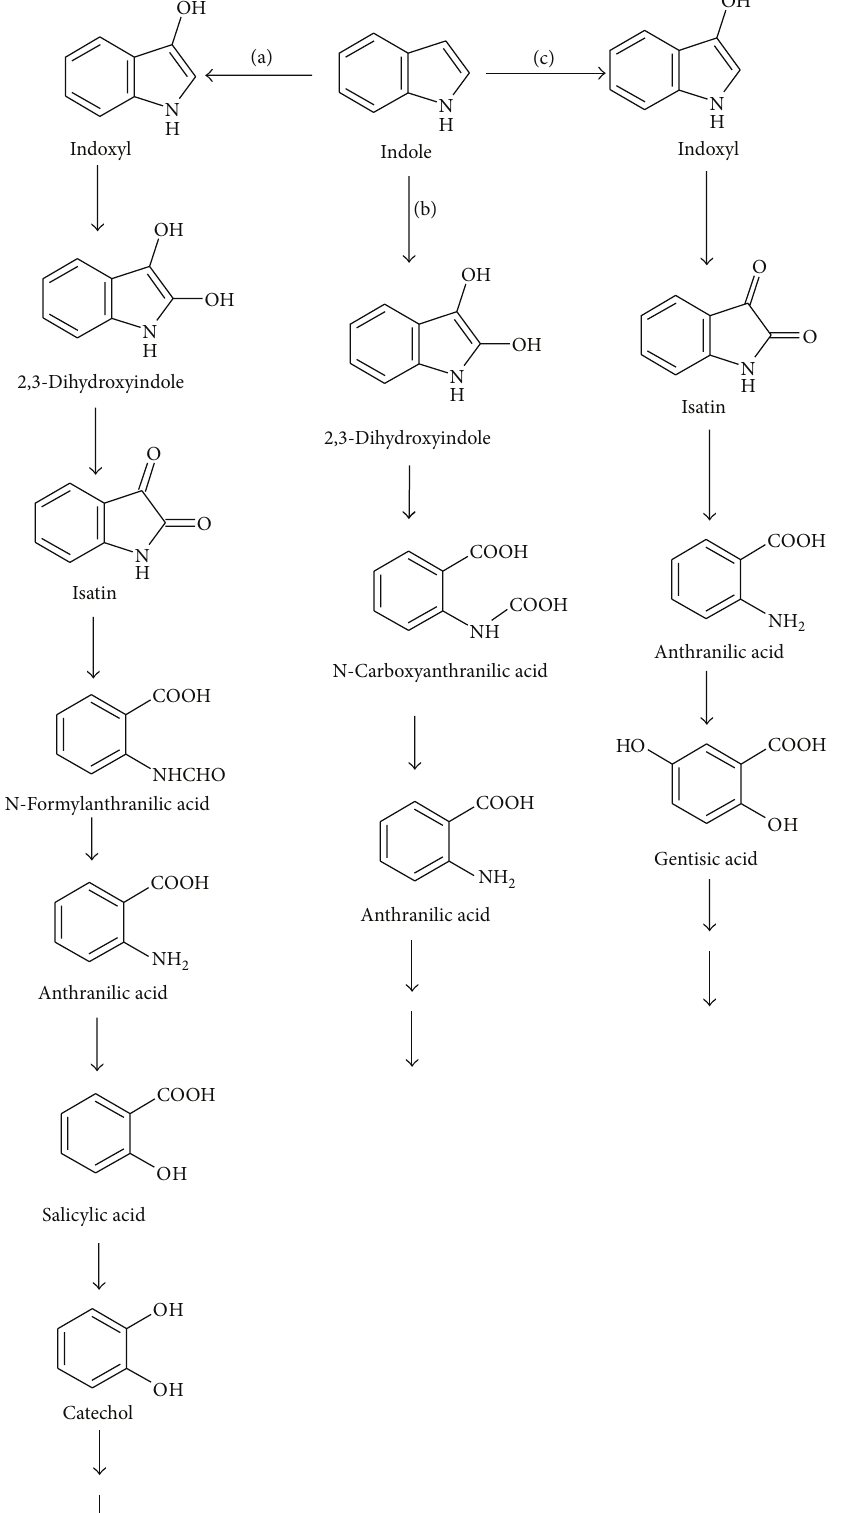
Figure 1: Metabolic pathways for mineralization of indole in (a) tap water bacterium [35] and (b) a gram positive coccus [36] and (c) an Alcaligenes sp. In 3